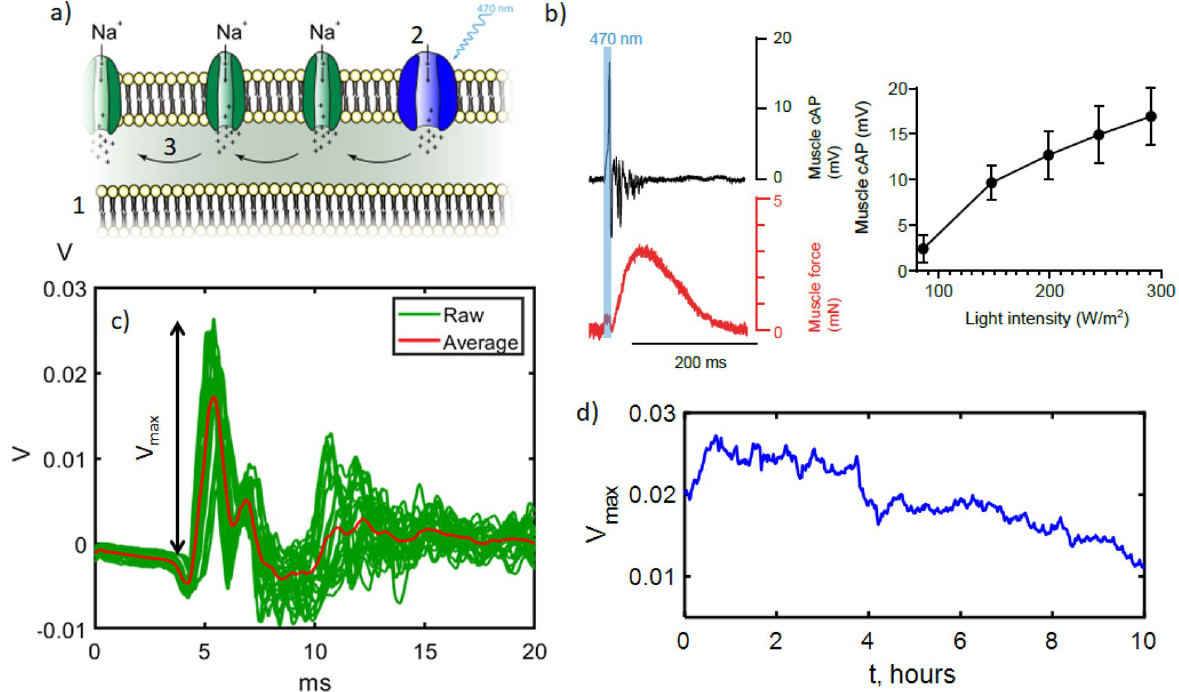
Figure 3. Mouse muscle electrophysiology and signal variation over time ( a ) Sketch of the biological signal generation process. In the muscle cell bi-lipid membrane (1) channelrhodopsin (2) opening triggers influx of Na + ions (3), creating an action potential running along the muscle. ( b ) Preliminary measurements taken on a separate setup of a single stimulation and readout via electrical probes (mV) and via muscle contraction force (mN). The strength of the signal as a function of light intensity is also shown. ( c ) Example of the readout of the biological signal in the magnetometer setup from a muscle (Muscle 1) by the electrical contact probe. Here t ms is when the stimulation light is applied. The red trace shows the average signal observed over all stimulations. ( d ) (left axis) Maximum size of the initial peak in the signal, which steadily drops by a factor of 2 over time as the muscle becomes fatigued.